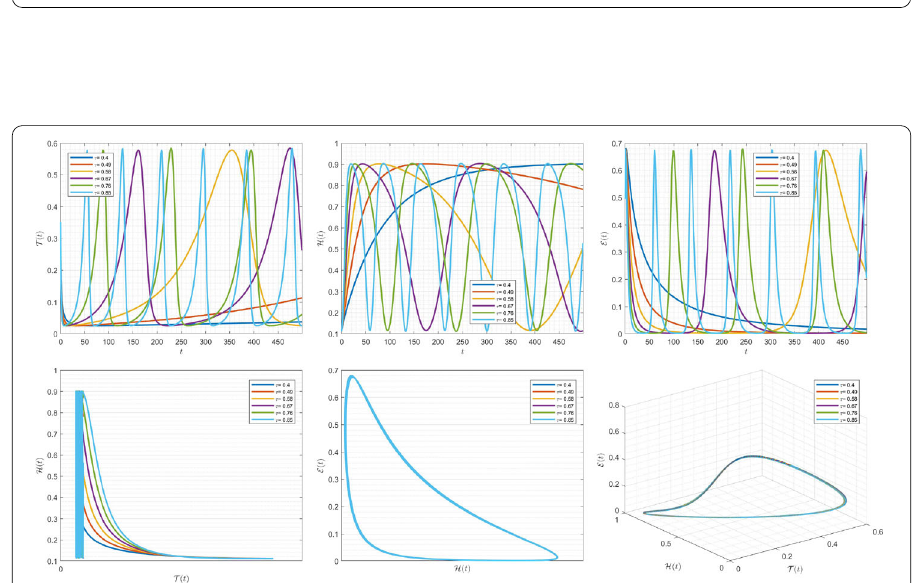
Figure 15 Simulations for solving (69) using (74) along with ( T (0), H (0), E (0)) = (0.3517,0.1115,0.4951) and β 12 =